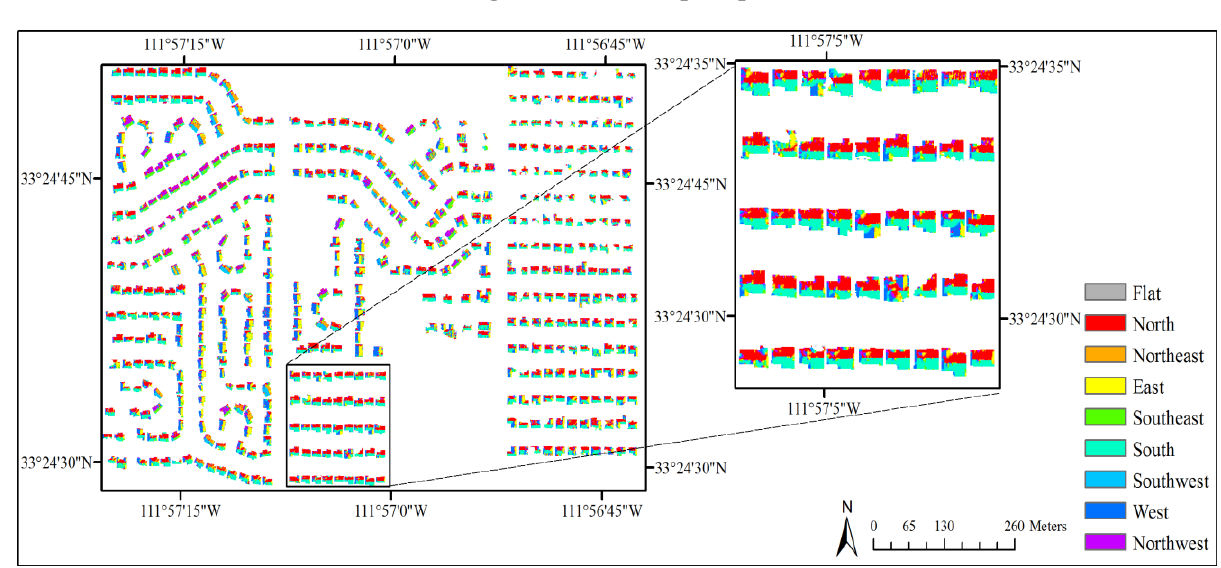
Figure 13. Rooftop slope.